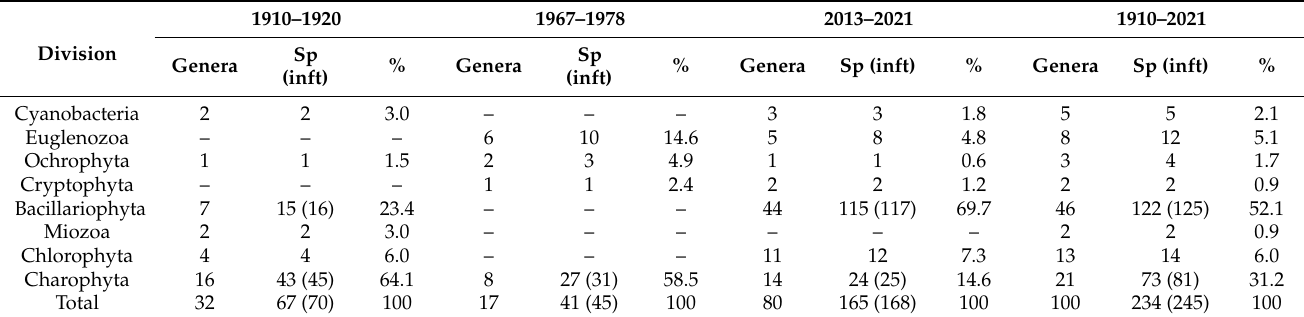
Table 2. Systematical composition of algae of the Nesamovyte Lake